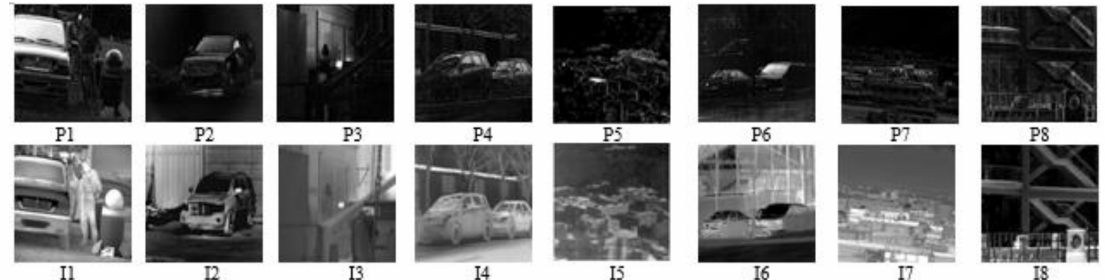
Figure 2. Eight groups of infrared polarization and infrared intensity experimental